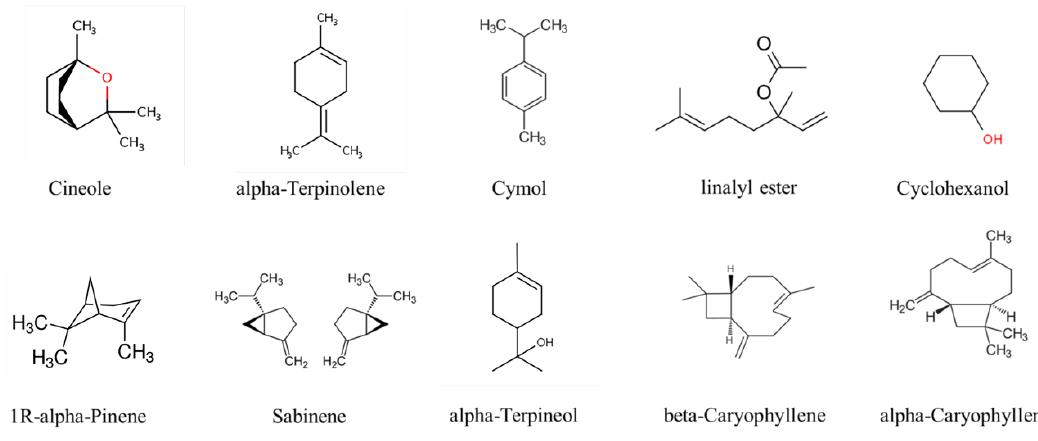
Figure 4. Chemical structures of marjoram oil’s components .